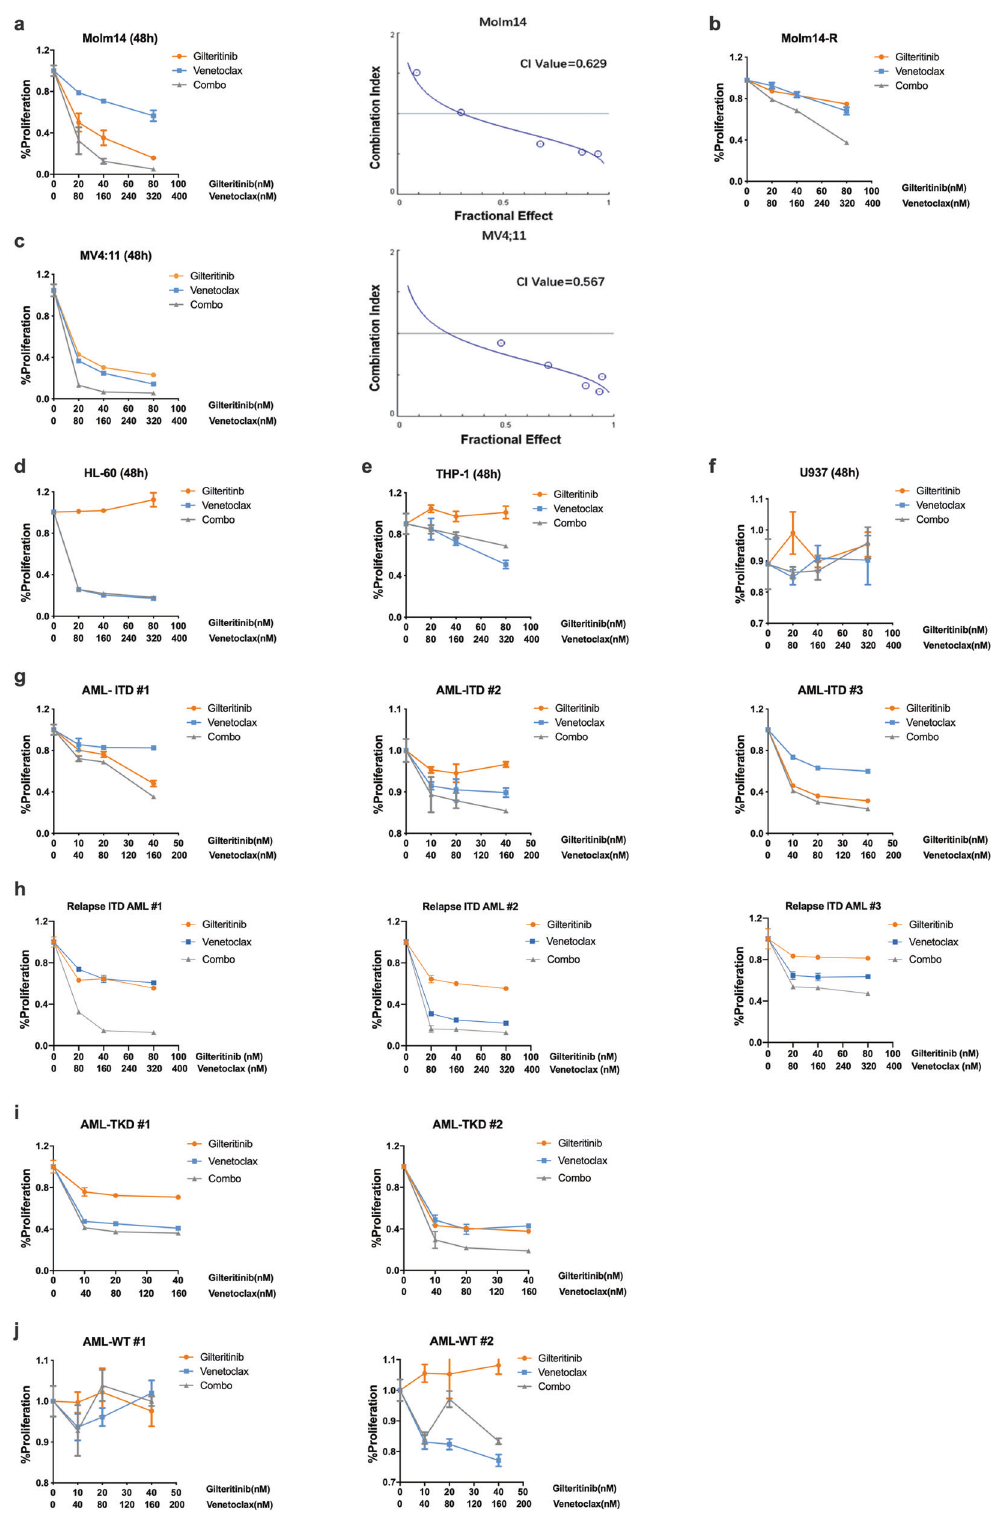
Fig. 1 Gilteritinib and Venetoclax synergistically inhibit the proliferation of FLT3/ITD cell lines and primary FLT3/ITD AML samples. 48 h MTT assay of cells treated with the indicated doses of Gilteritinib and Venetoclax: a Molm14, b Molm14 cells resistant to 60 nM Lestaurtinib (Molm14-R), c MV4;11, d HL-60, e THP-1, f U937, g Primary de novo AML patient samples with FLT3/ITD mutation (AML-ITD#1, AML-ITD#2, AML-ITD#3), h Primary AML samples from relapsed patients with FLT3/ITD mutations (Relapse ITD AML #1, Relapse ITD AML #2, Relapse ITD AML #3), i Primary AML patients with FLT3/TKD mutation, or j without FLT3 mutations (AML-WT#1,